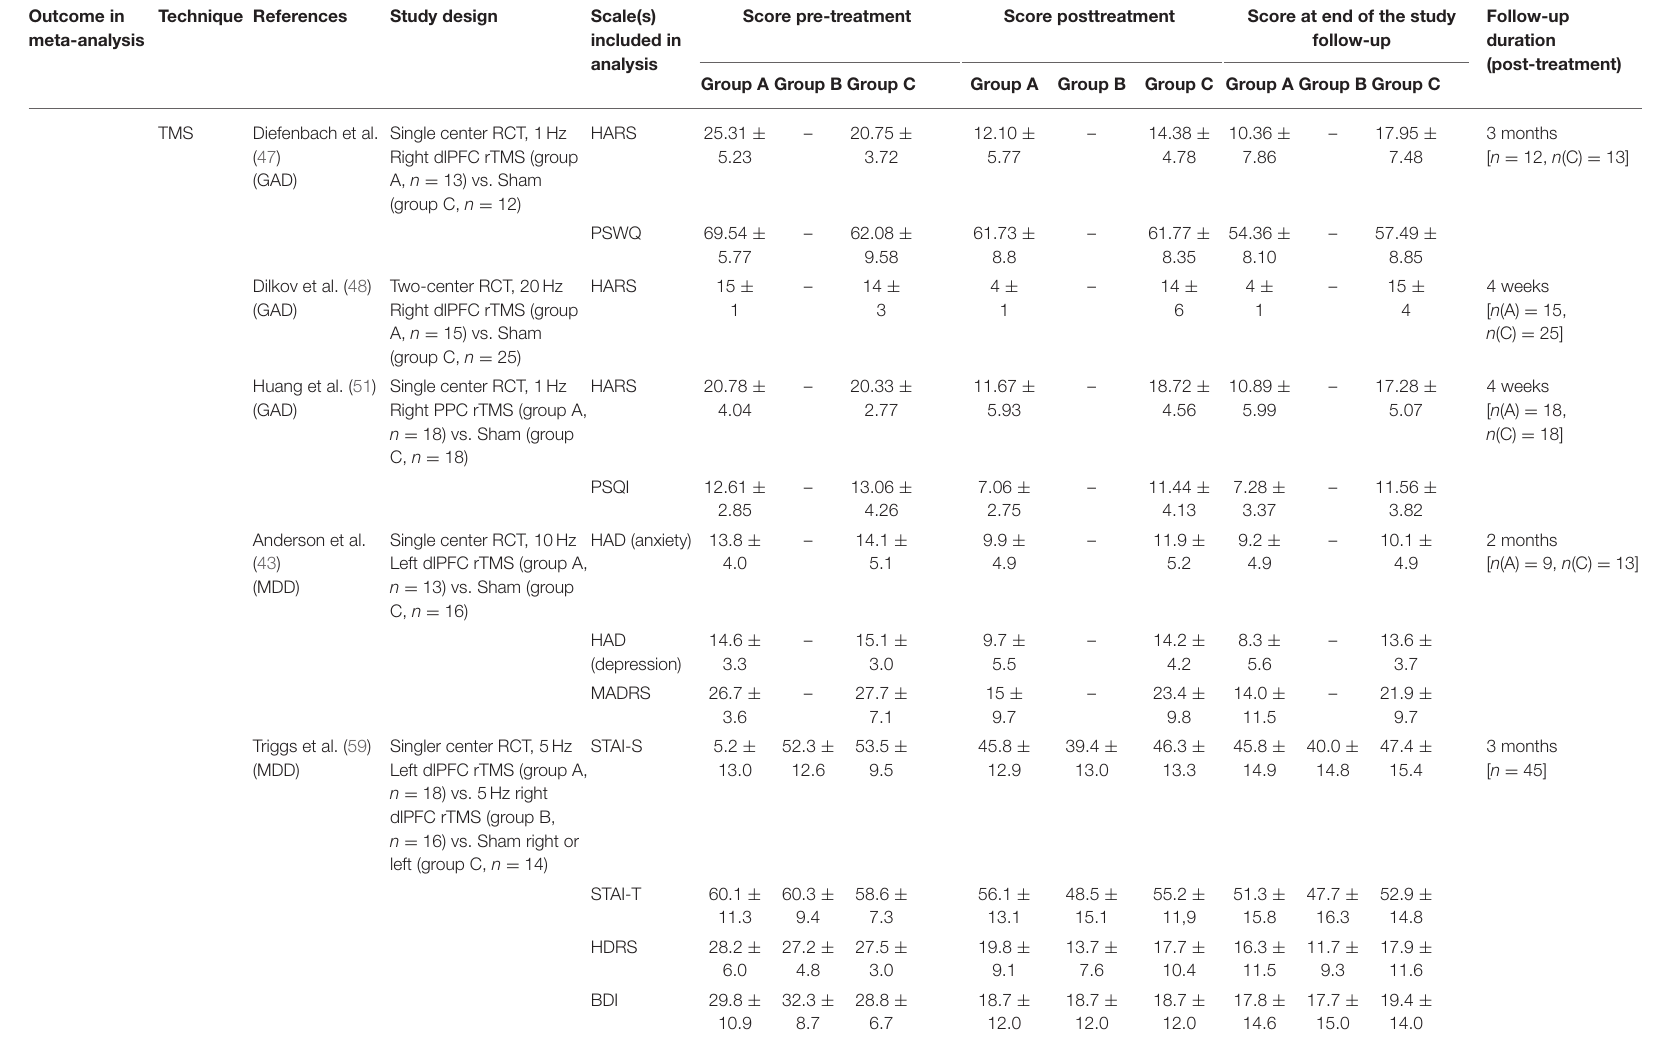
TABLE 4 | Raw data of psychometrics in included studies. Outcome in Technique meta-analysis